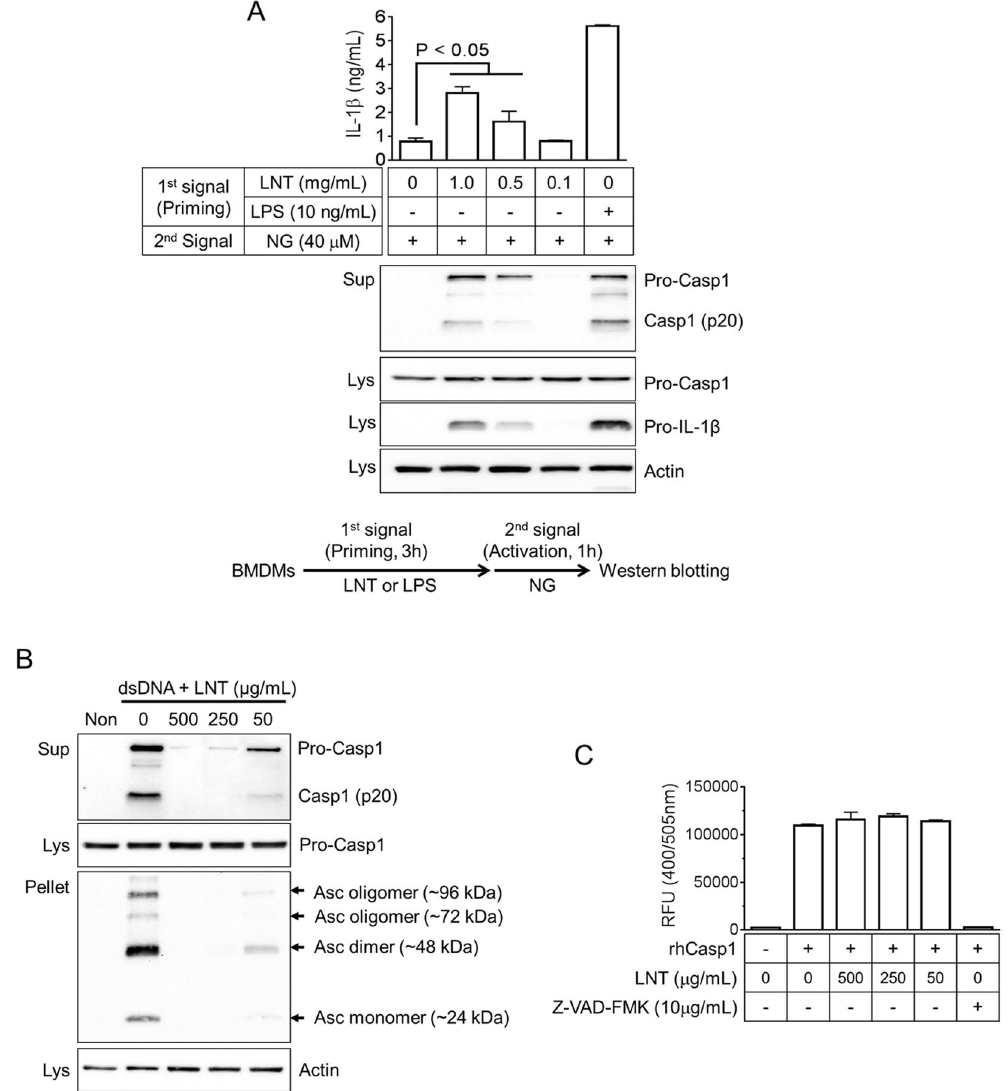
Figure 4. Effect of lentinan on priming step of inflammasome activation and formation of Asc pyroptosome. ( A ) BMDMs were treated with lentinan (LNT) or LPS as the 1 st signal, after which cells were replaced by media containing nigericin (NG, 2 nd signal). Secretion of IL-1 β was measured by ELISA, and Casp1 secretion and pro- IL1 β expression were analyzed by immunoblotting. ( B ) LPS-primed BMDMs were transfected with dsDNA in the presence of LNT. Casp1 secretion and Asc pyroptosome formation were analyzed by immunoblotting using cell culture supernatants (Sup), cell lysates (Lys), and cross-linked pellets (Pellet) from whole cell lysates. ( C ) Recombinant human caspase-1 (rhCasp1) was incubated with its substrate (YVAD-pNA) in the presence of LNT as indicated. Bar graph presents the mean ± SD of relative fluorescence unit